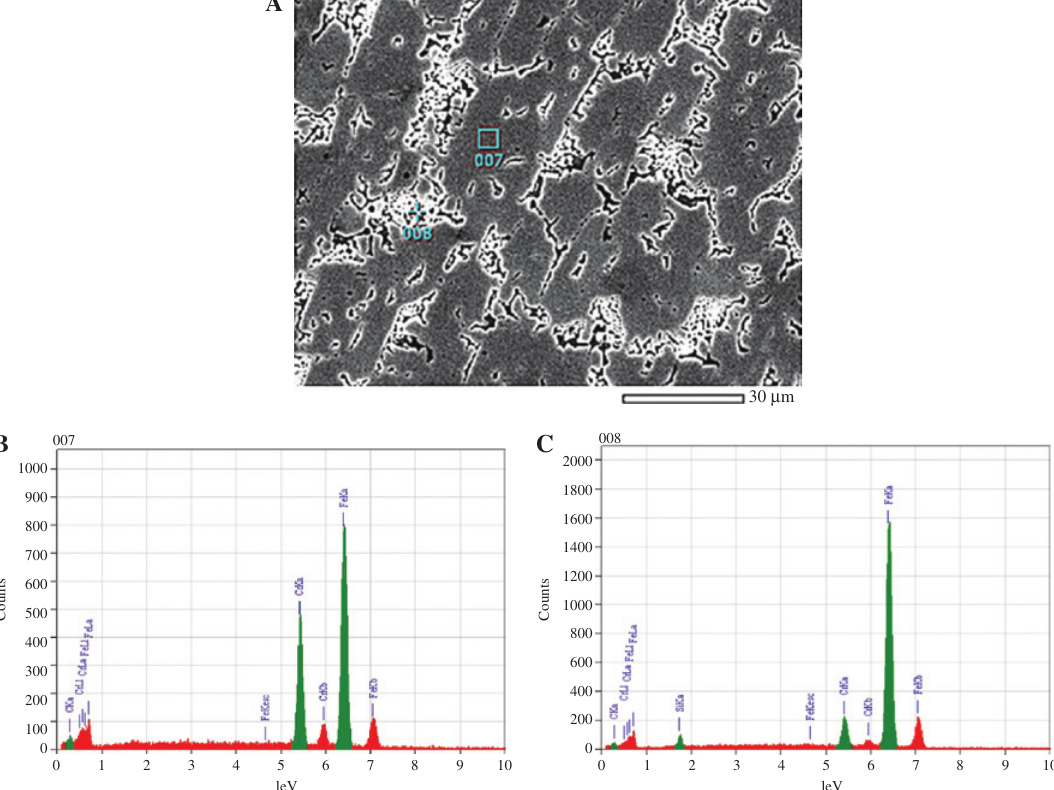
Figure 3 Microstructure and chemical composition (EDS) analysis of FeCrBC alloy cladding: (A) microstructure of FeCrBC alloy cladding, (B) EDS analysis of point 007, (C) EDS analysis of point 008.